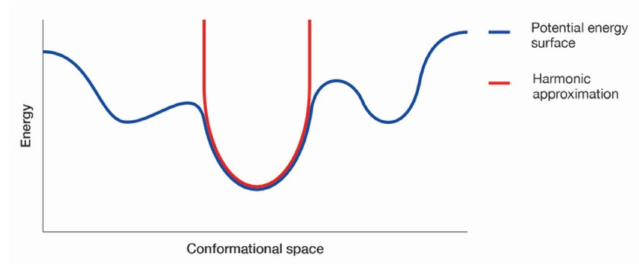
Figure A6. Energy landscape and harmonic